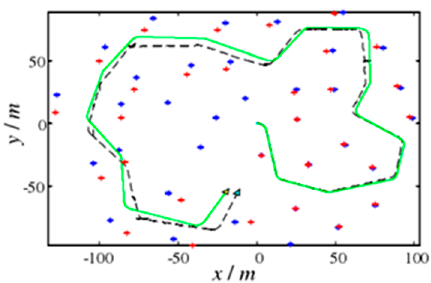
Figure 8. EKF algorithm simulation.